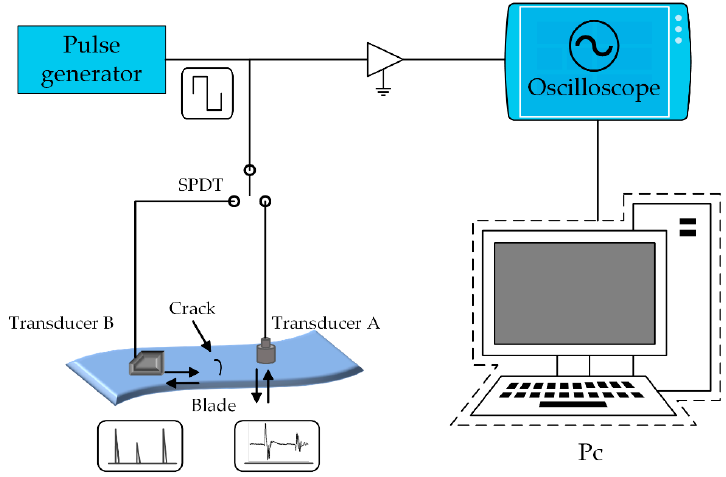
Figure 8. Diagram of the used experimental